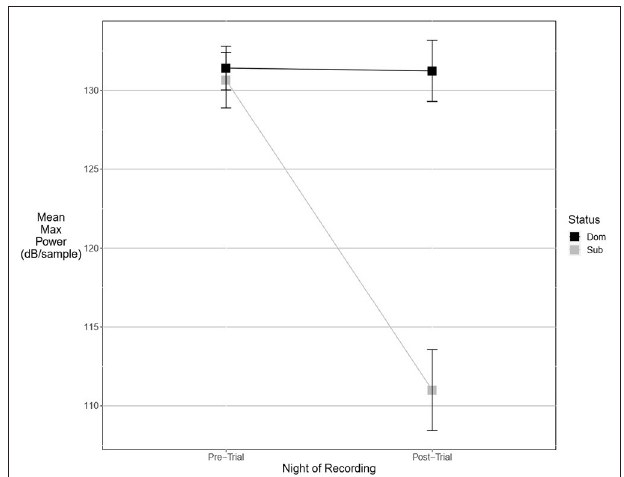
FIGURE 3 | Dominant males signal with higher power only after an aggressive interaction. Graph of mean estimates of model: Power ∼ (1|ID) + (1|Pair) + Score Result *Night of Recording.